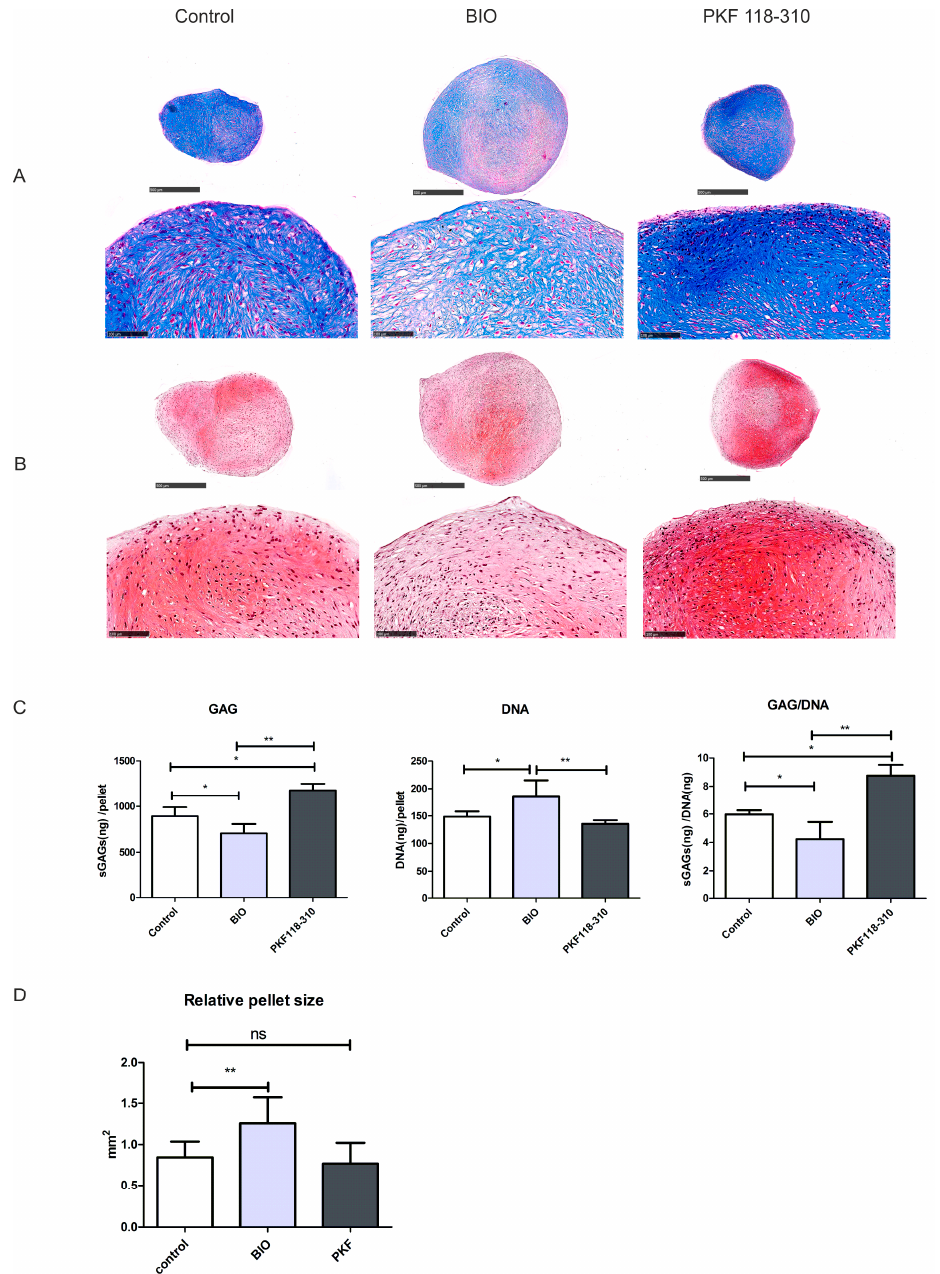
Figure 3. Activation of the canonical WNT signaling pathway inhibits cartilage formation. The effects of small molecules on cartilage formation and pellet size after 5 weeks of culture. ( A ) Alcian blue staining was performed to examine the deposition of sulfated glycosaminoglycans (GAGs) in midsagittal paraffin sections of hMSCs pellets; nuclei were counterstained with nuclear fast red. The upper panel indicates the overview of each pellet, scale bar = 500 µm; the lower panel indicates magnified pictures, scale bar = 100 µm; ( B ) Safranin O staining; nuclei were counterstained with hematoxylin. The upper panel indicates the overview of each pellet, scale bar = 500; the lower panel indicates magnified pictures, scale bar = 100 µ m; ( C ) GAG and DNA production in pellet; ( D ) Quantification of the average size of the pellets. * p < 0.05, ** p < 0.01. Error bars represent